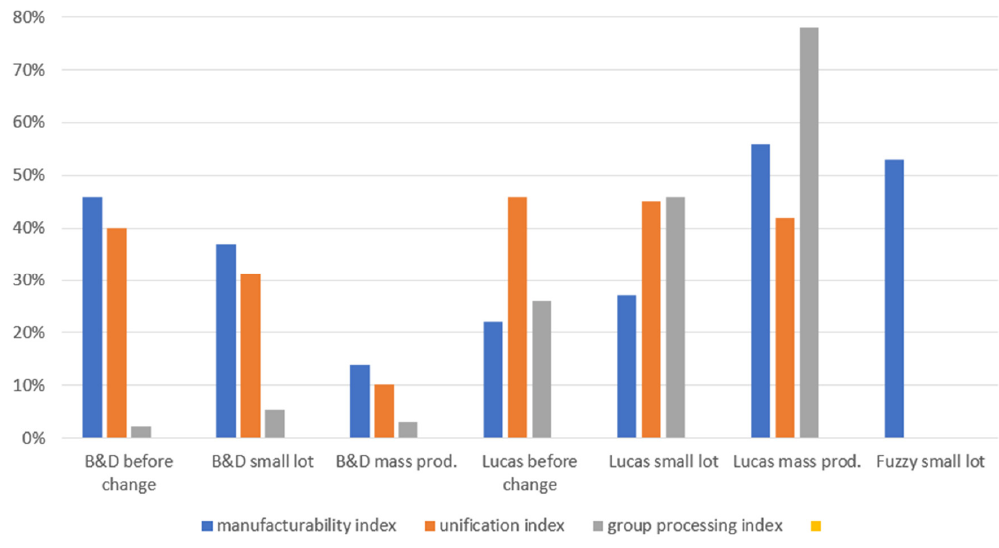
Figure 22. Comparison of methods for gear groups.